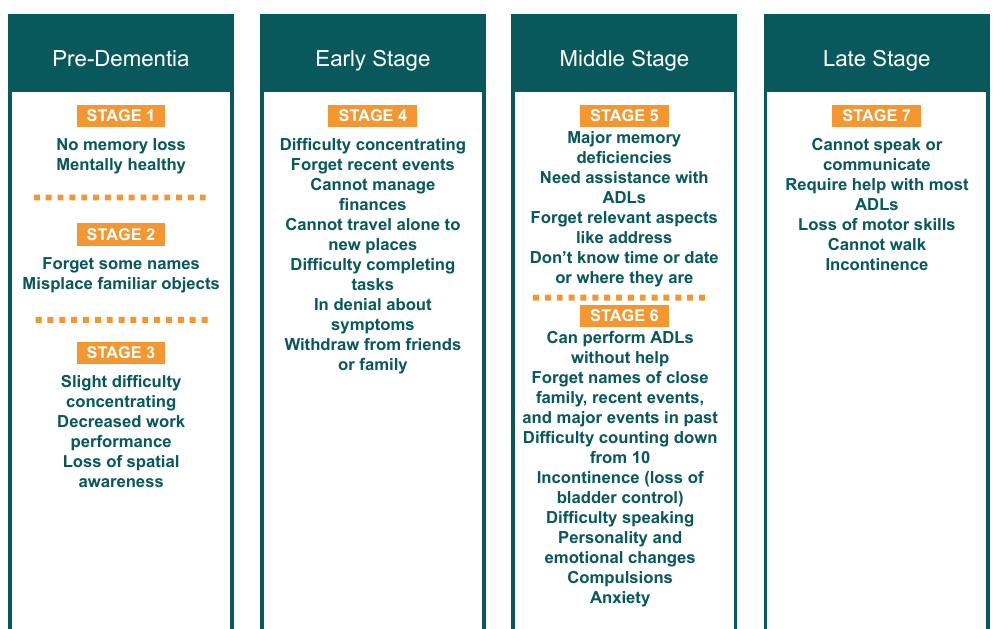
Figure 1. Stages of Dementia (based on the GDS